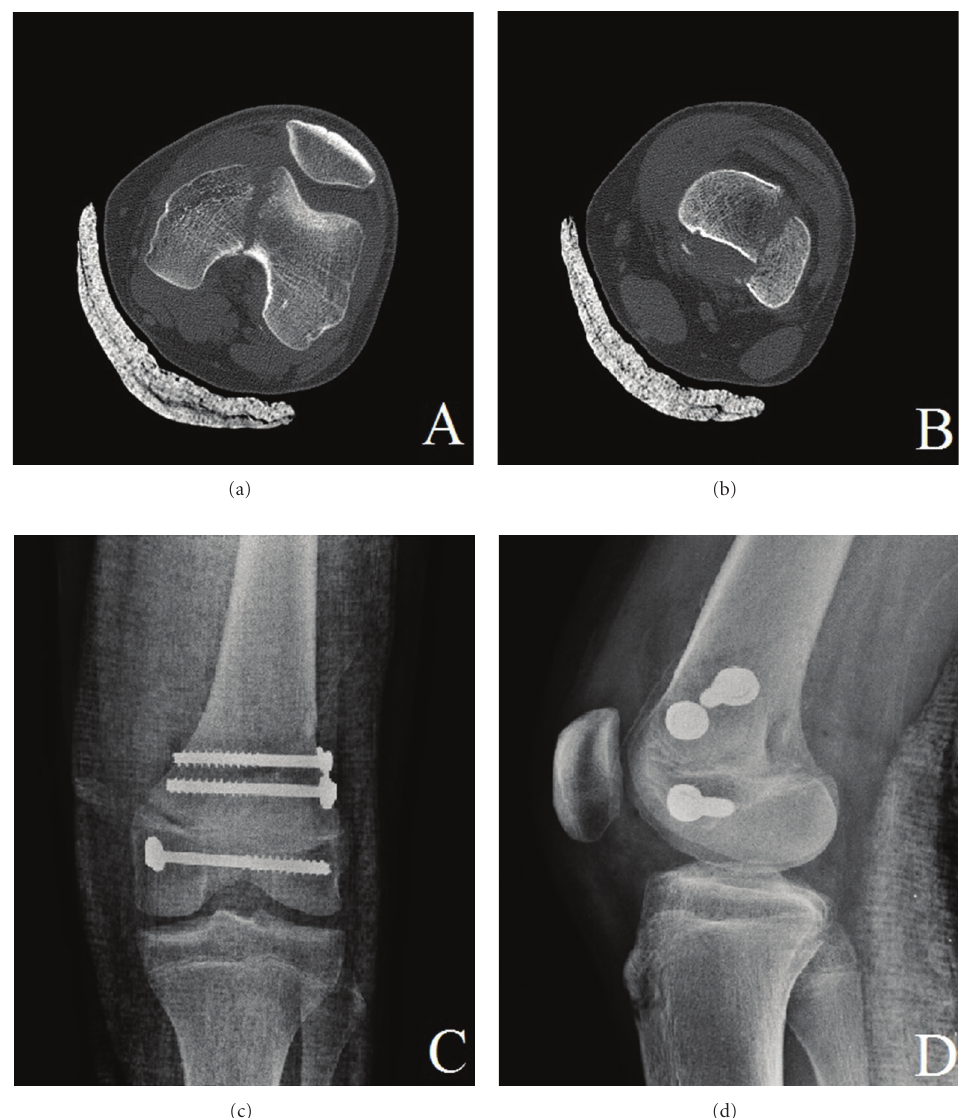
Figure 2: Computed tomography of physeal (a) and metaphyseal (b) fracture. Postoperative anteroposterior and lateral radiograph of the left knee